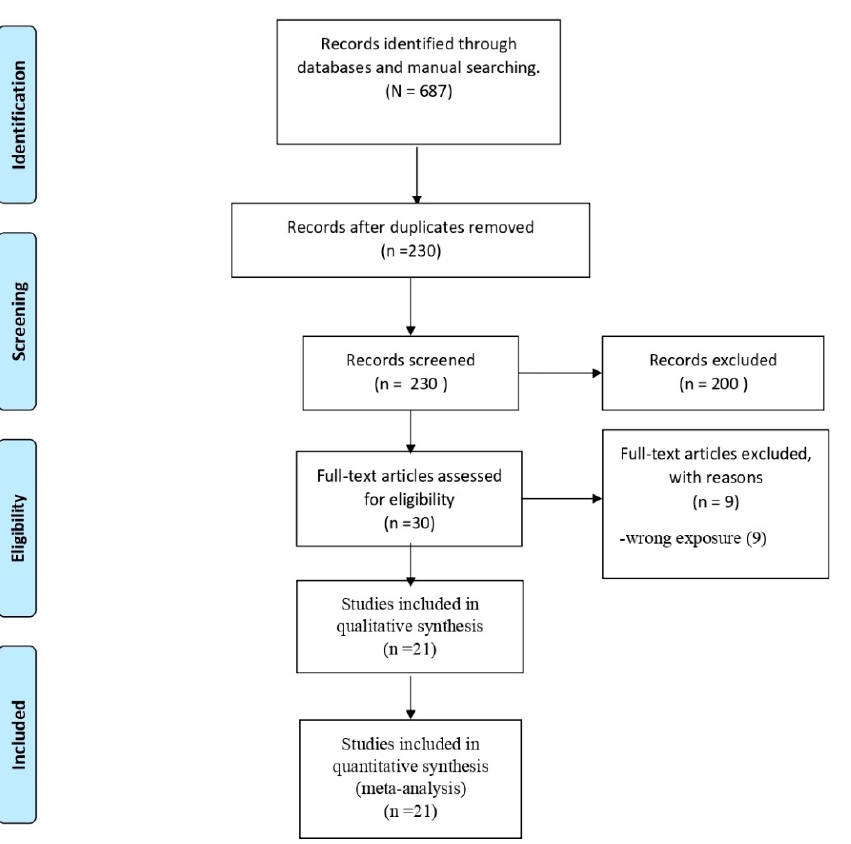
Figure 1. PRISMA Flow Diagram.